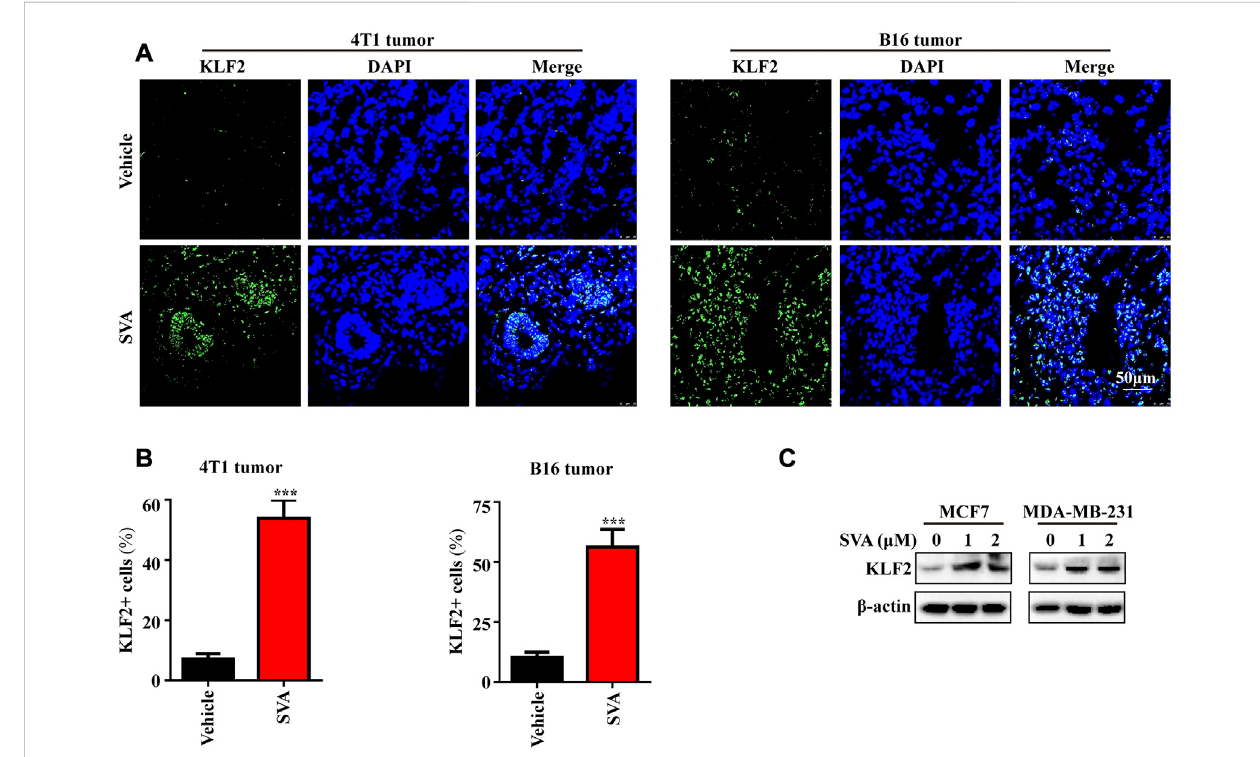
FIGURE 9 The induction of KLF2 expression by Simvastatin. (A, B) Immuno fl uorescence analysis of KLF2 was conducted on 4T1 tumors and B16 tumors from the vehicle and 15 mg/kg/day SVA groups. Bar = 50 μ m. (C) To examine KLF2 expression in MCF7 and MDA-MB-231 cells after treatment with 0, 1 and 2 μ M SVA by western blotting. p , p < 0.05; pp , p < 0.01; ppp , p < 0.001; ns, no signi fi